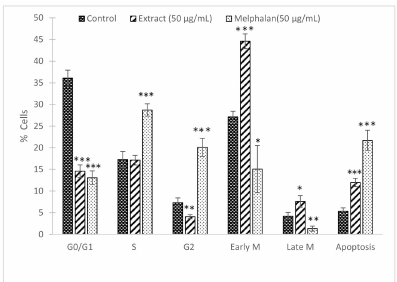
Figure 4. Cell cycle analysis in MeWo cells after exposure to H. petiolare extract (50 µ g / mL) and Melphalan (50 µ g / mL). NucRed TM Live 647 stain dye. The results are presented as the percentage of cells detected in each phase. Data are expressed as the mean ± SD, n = 3. * p < 0.05, ** p < 0.01 and *** p < 0.001 compared to